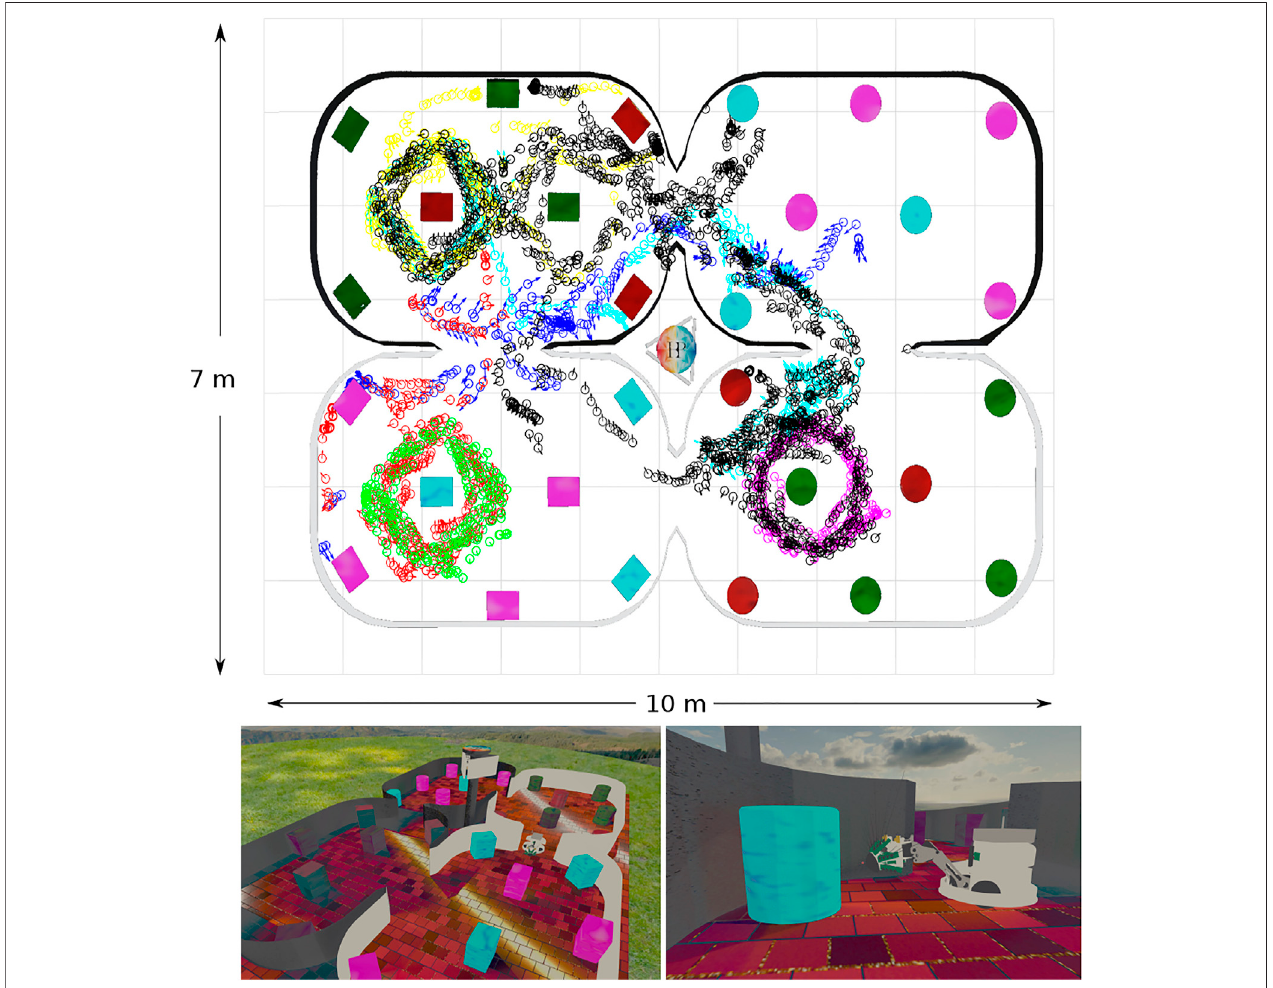
FIGURE3| SimulatedWhiskEyeintheNeuroRoboticsPlatform.Toppanel)Quiverplotofheadposes( x , y , θ )atsamplepointstakenasthetrainingset(black)and6 test sets (blue:1, red:2, green:3, magenta:4, cyan:5, yellow:6) The arena walls and coloured objects have been superimposed onto the quiver plot for reference. Lower panels) Screen shots taken from the simulator showing the arena and simulated WhiskEye robot as it explores the arena. The tactile attention model used to control the physical platform is the same as used in the simulator.